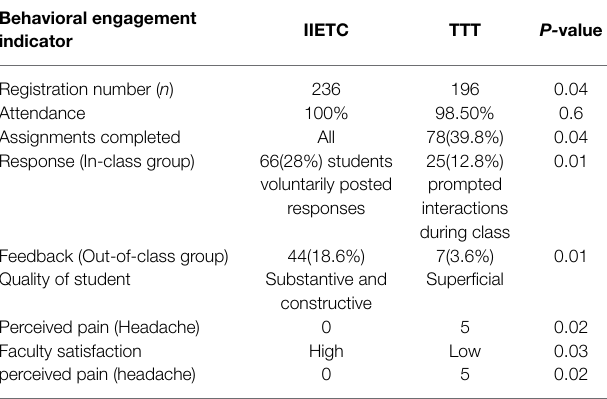
TABLE 2 | The impact of IIETC on the students’ performance of biology